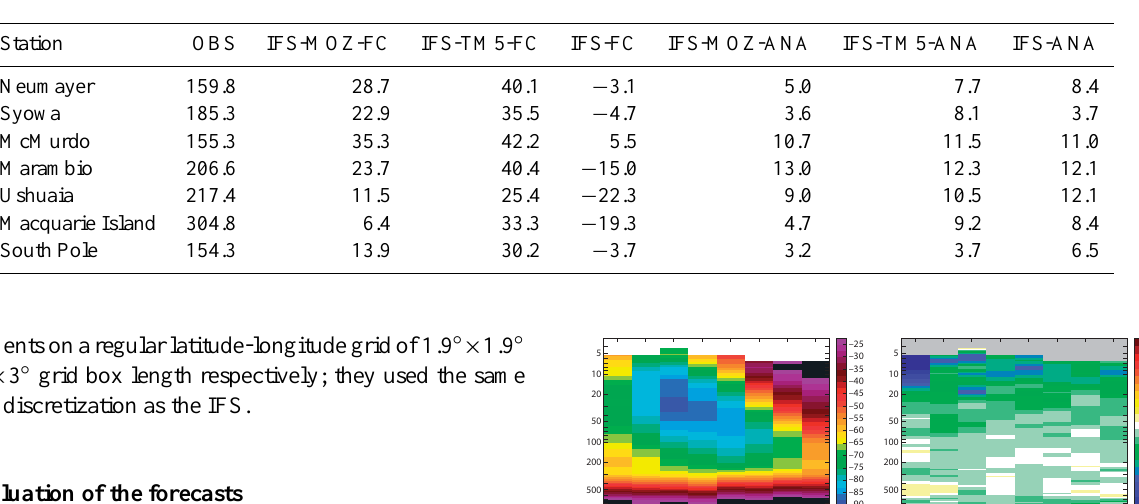
Table 4. Average of ozone columns inDU derived from sondes (OBS) and biases (model minus observation) for all model configurations and stations (see Table 3).